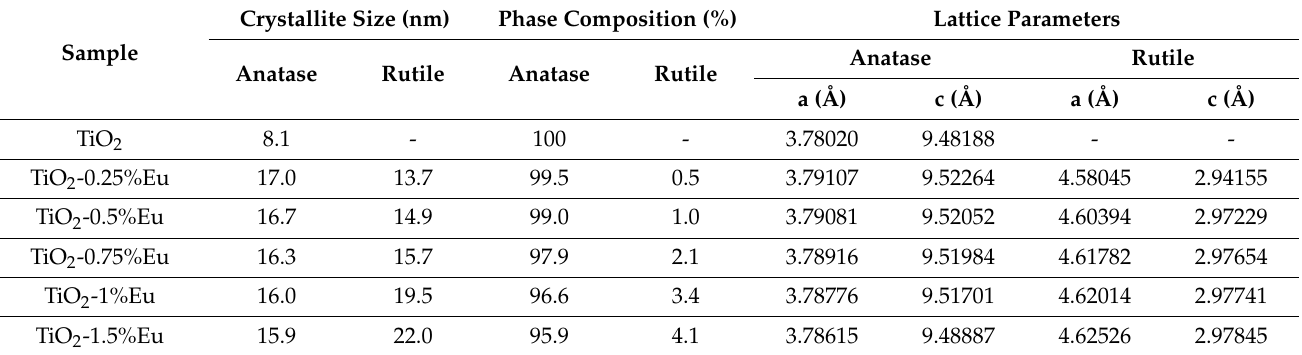
Table 1. The average crystallite size, phase composition, and lattice parameters of the obtained TiO 2 -Eu systems.